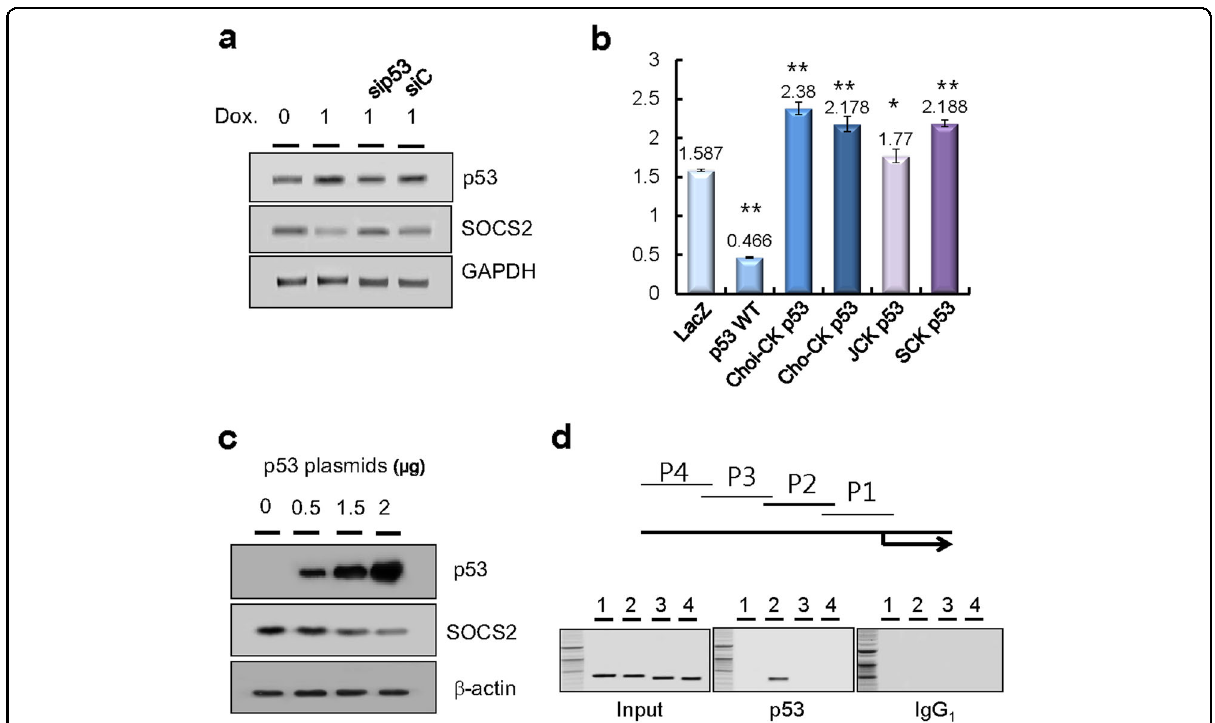
Fig. 2 Transcriptional regulation of SOCS2 by p53. a Inverse regulation of SOCS2 in the HCT116 p53(+/+) cells simultaneously treated with doxorubicin and siRNA against p53 (sip53) versus control (siC). b SOCS2 promoter activity in wild-type or mutant p53 HEK293 cells. Values represent the mean ± SD from three independent experiments. * P < 0.05; ** P < 0.01. c Inhibition of SOCS2 protein expression in the HCT116 p53( − / − ) cells transfected with p53 expression plasmids in a dose-dependent manner. d Identi fi cation of p53 binding to the SOCS2 promoter by chromatin immunoprecipitation. Crosslinked chromatin from HCT116 cells (p53 +/+ ) was immunoprecipitated with anti-p53. Chromosomal fragments were ampli fi ed with SCOCS2 primer pair P2 for 436-bp fragment in sample and no fragment in negative control (IgG 1 ). NC negative